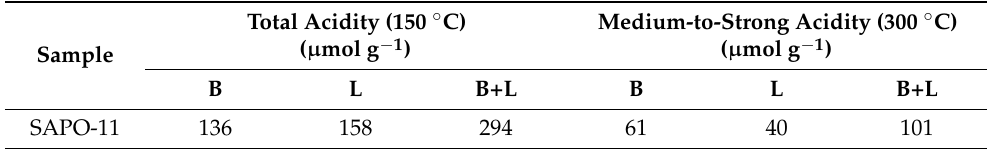
Table 1. Surface acidity of SAPO-11 calculated using pyridine-IR spectroscopy method. B = Brønsted acid sites and L = Lewis acid